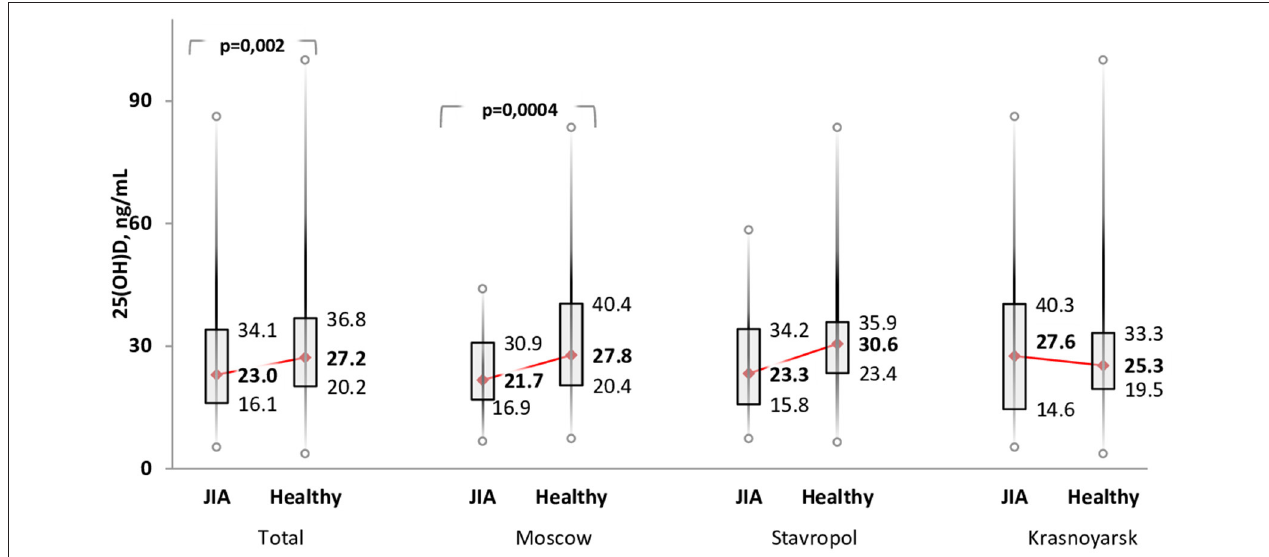
FIGURE 1 | Comparison of the level of vitamin D (serum calcidiol, ng/mL) between the JIA and control group by geographical region included in the analysis.